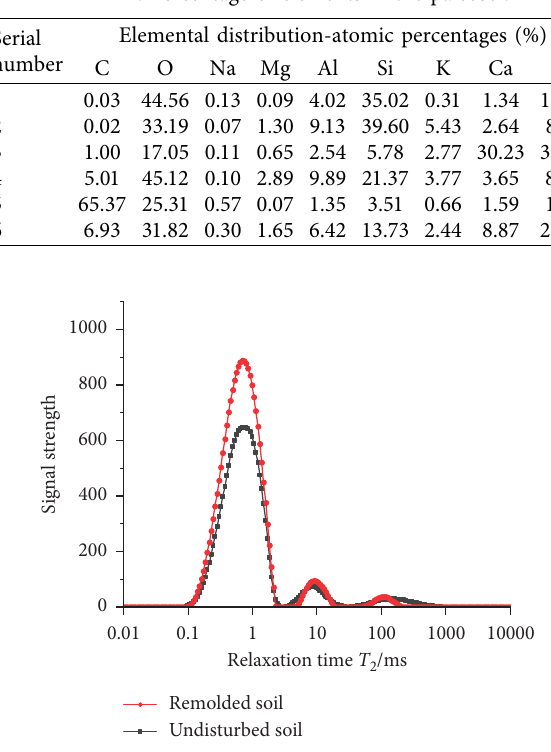
Figure 6: (T) 2 spectra of the paleosol.